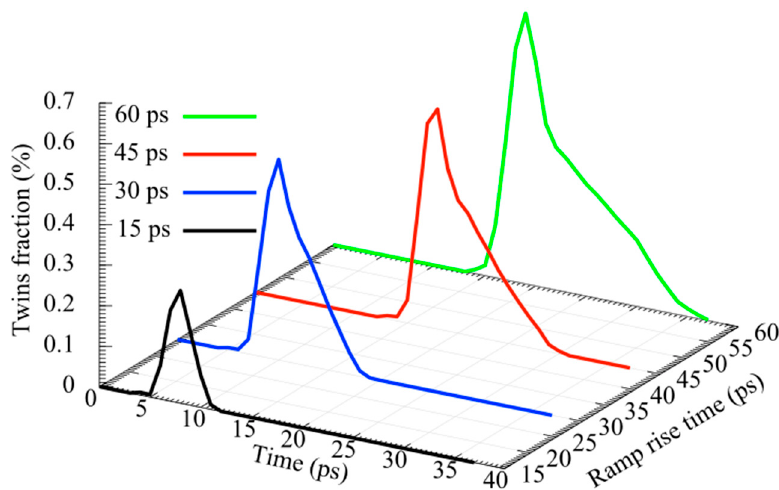
Figure 2. Temporal evolution of the twin fraction for various ramp rise times.